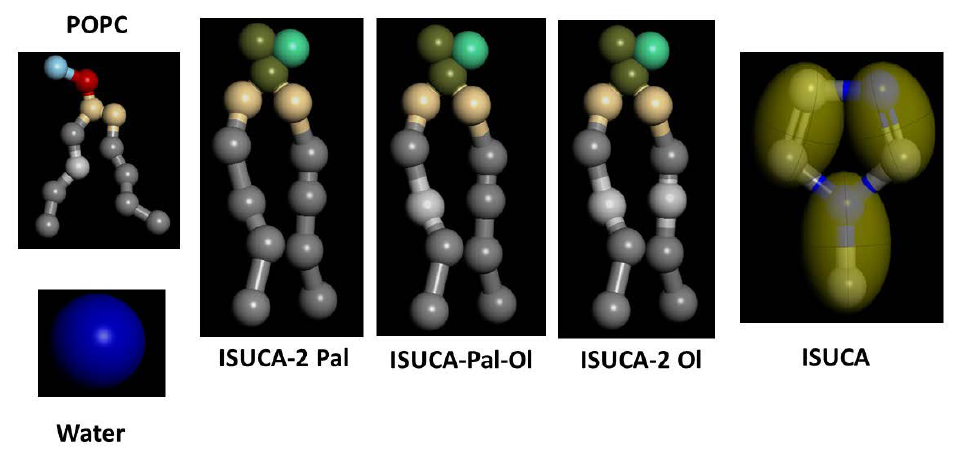
Figure 12. Structures of the molecules in the CG model.